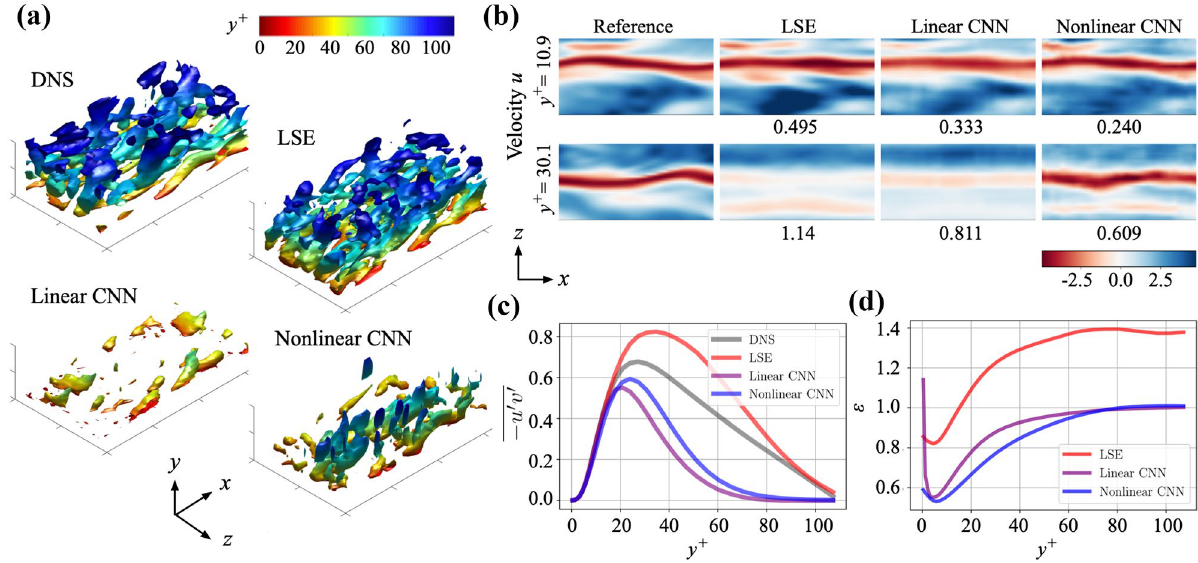
Figure 7. Estimation of turbulent channel flow from streamwise wall-shear stress. ( a ) Isosurfaces of the Q criterion ( Q + = − 0.005 ) . ( b ) x − z sectional velocities at y + = 10.9 and 30.1. The values underneath the contours report the L 2 error norm for each velocity attribute. ( c ) Reynolds shear stress − u ′ v ′ . ( d ) Dependence of the ensemble L 2 error norm over three velocity components on the y